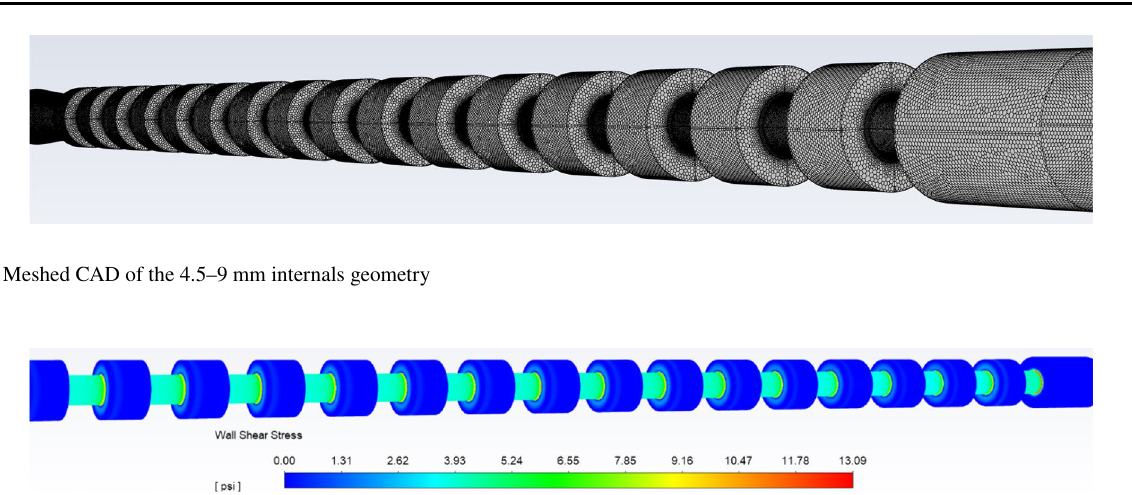
Fig. 7 Wall shear stress (psi) obtained in the CFD simulation of 4.5–9 mm internals with flow of 564BPD and 1000 ppm of HPAM concentra- tion